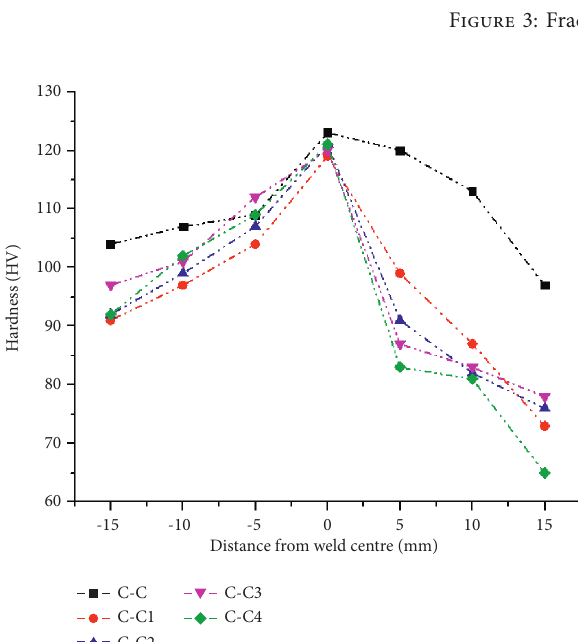
Figure 4: Hardness analysis in different